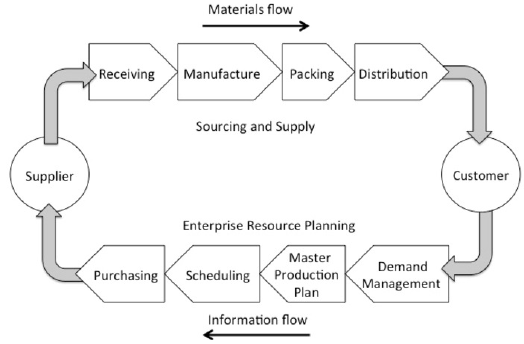
Fig. 2 The basic structure of supply chain